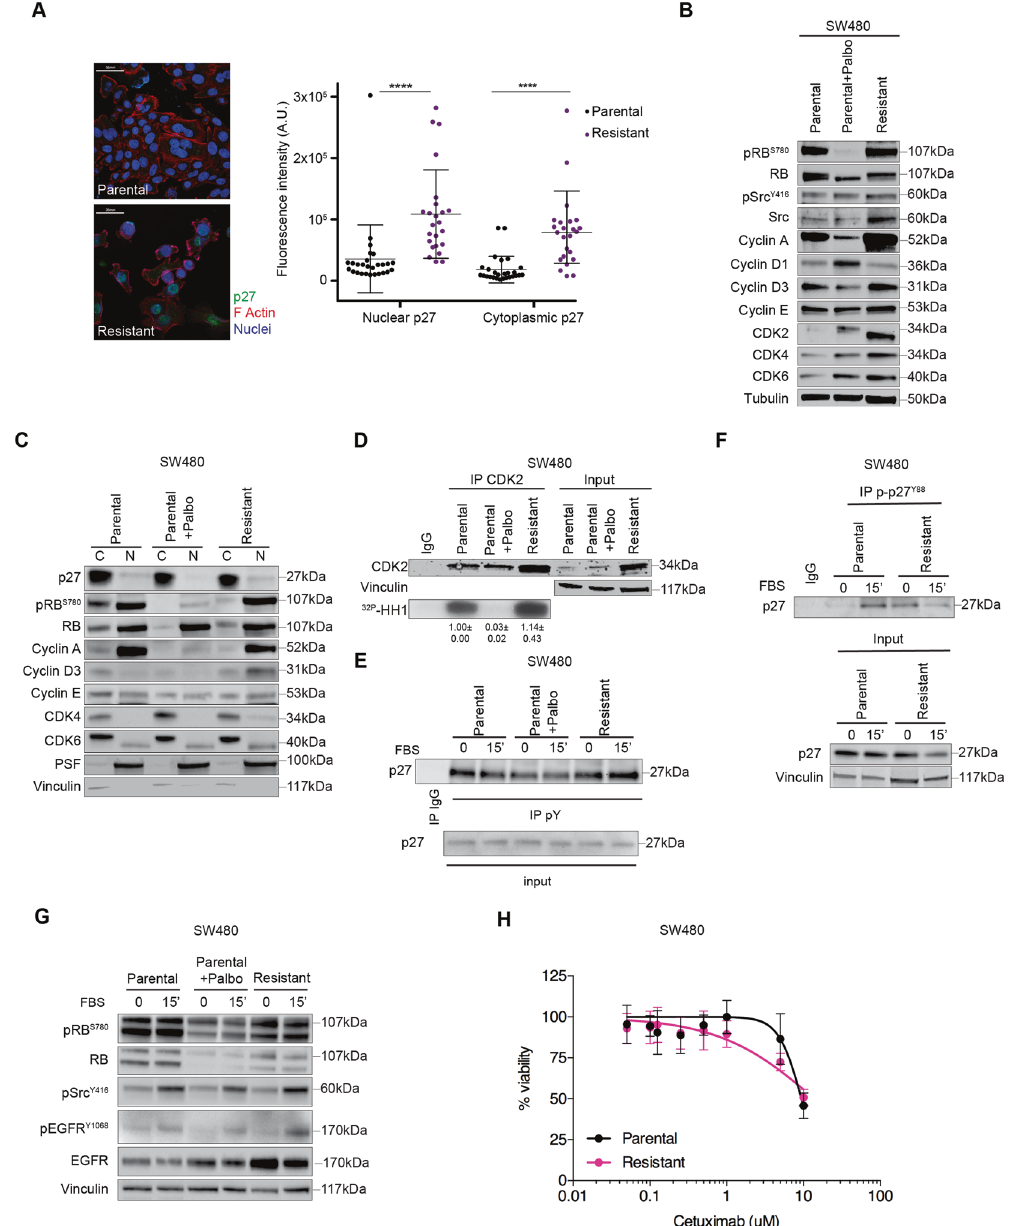
Fig. 4 Palbo-resistant phenotype relies on phosphop27-CDK4 interaction. A Left: Typical images of immuno fl uorescence evaluating p27 expression (green) in parental (top) and resistant (bottom) SW480 cells. Staining of F-Actin (red) and nuclei (To-Pro-3, blue) was used to evaluate p27 subcellular localization. Right: Graph reports the quanti fi cation of p27 expression (expressed as arbitrary units) in nuclear and cytoplasmic compartments. Each dot corresponds to one cell. Mann – Whitney test was used for statistical analysis. B Western blot analysis evaluating the expression of the indicated cell-cycle proteins in SW480 cells treated or not with Palbo (2 μ M, 24 h) and resistant cells cultured in presence of 2 μ M Palbo. C Expression of the indicated proteins in the nuclear (N) and cytoplasmic (C) fractions of SW480 cells treated or not with Palbo (2 μ M, 24 h) and resistant cells, as indicated. D Kinase assay evaluating the activity of endogenous CDK2 immunoprecipitation from parental SW480 treated or not with 2 µM Palbo for 24 h and Palbo-resistant cells cultured in the presence of 2 µM Palbo. In the kinase assay recombinant Histone H1 ( 32P -HH1) was used as substrate. Input indicates the expression of CDK2 in corresponding cell lysates and vinculin was used as loading control. Immunoglobulin G (IgG) represents the control IP using an unrelated antibody. E Co-immunoprecipitation (IP) analysis of endogenous thyrosin phosphorylated proteins (pY) in SW480 parental cells, treated or not with Palbo (2 μ M, 24 h), and Palbo- resistant cells, serum starved (0) and released with FBS for 15 ’ , as indicated. IP indicates the expression of pY-p27. Input stands for the expression of indicated proteins in corresponding cell lysates and vinculin was used as loading control. F Immunoprecipitation (IP) analysis of endogenous phosphorylated p27 Y88 in SW480 parental and resistant cells, serum starved (0) and released with FBS for 15 ’ . Immunoglobulin G (IgG) represents the control IP using an unrelated antibody. Input indicates the expression of total p27 in corresponding cell lysates and vinculin was used as loading control. G Expression of the indicated proteins and phospho-proteins in cell lysates used in the IP assays shown in E and F . H Graph reports the cell viability of parental (black line) and resistant (pink line) SW480 cells, treated for 72 h with increasing doses of Cetuximab and evaluated using the MTS assay. Values from untreated cells represent 100% viability. Data represent the mean (±SD) of three independent experiments performed in